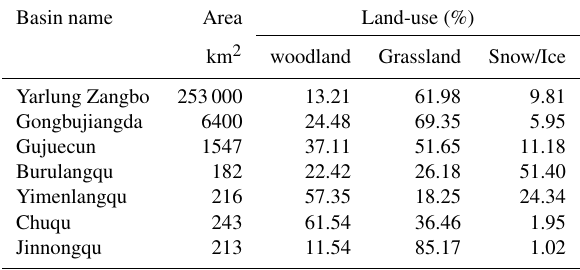
Table 1. Area and land-use of the interested basins. Basin name